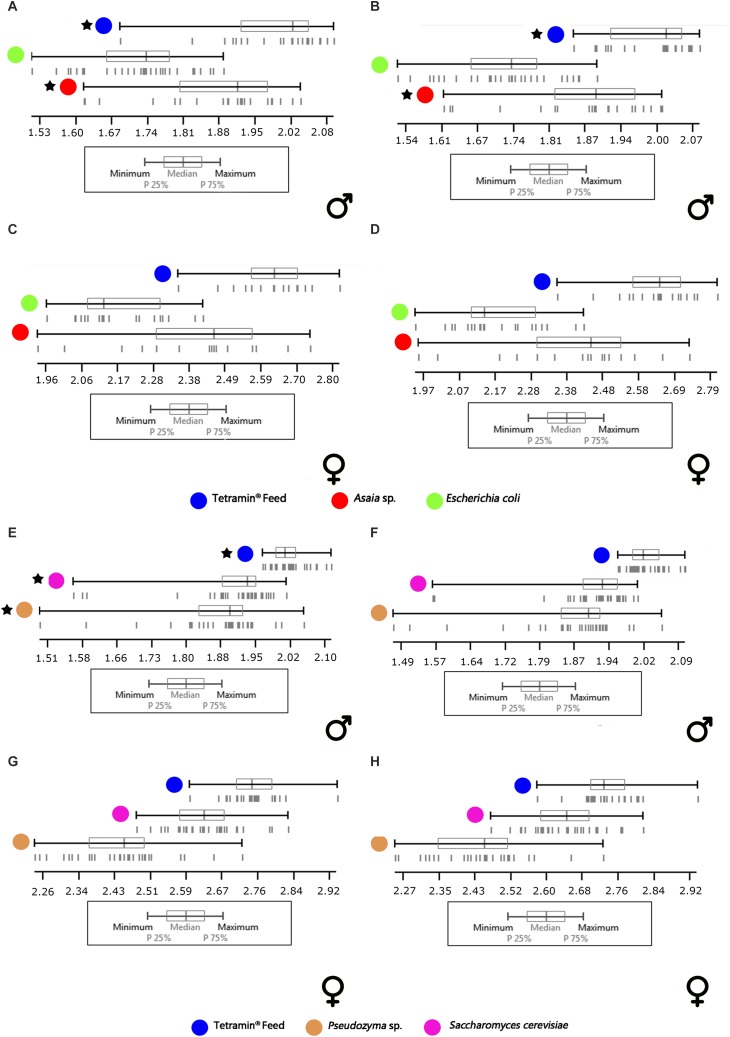
Descriptive statistics of right (B,D,F,H) and left (A,C,E,G) wing centroid sizes (in mm) of males and females from different diets. (A–D) Comparison between control diet (Tetramin®) and Gram-negative bacteria (Asaia sp. and E. coli). (E–H) Comparison between control diet [Tetramin (R)] and Yeasts (Pseudozyma sp. and S. cerevisiae). Vertical lines: individuals. Asterisks: Non-normal distribution.